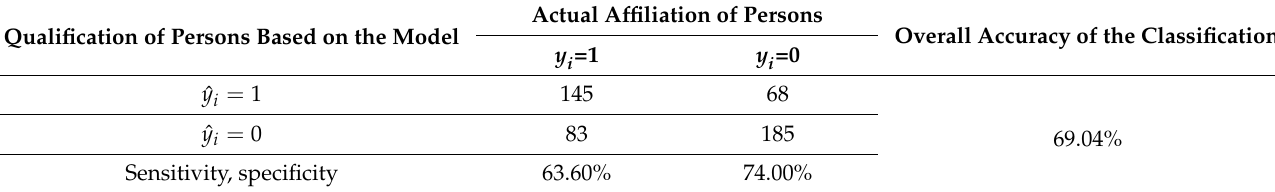
Table 3. Classification accuracy of the logit